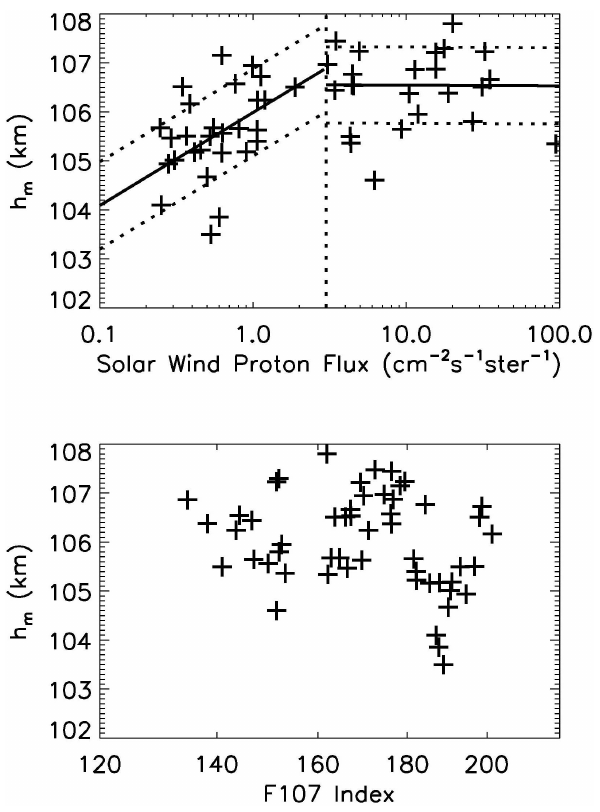
increase of neutral temperature raises the peak altitude by ∼